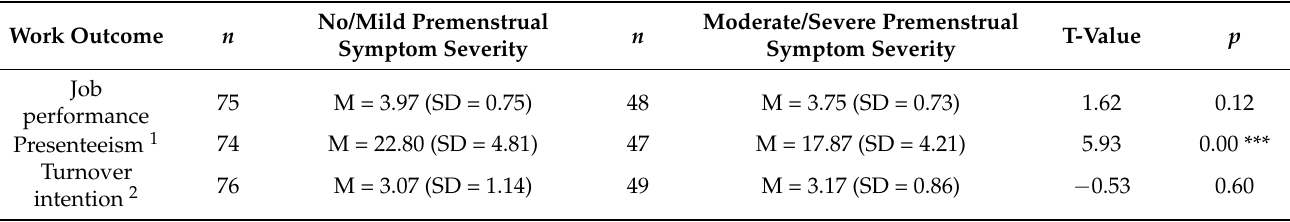
Table 1. Results of independent t-tests between premenstrual symptom severity and job performance, presenteeism, and intention to leave the current employing organization (turnover